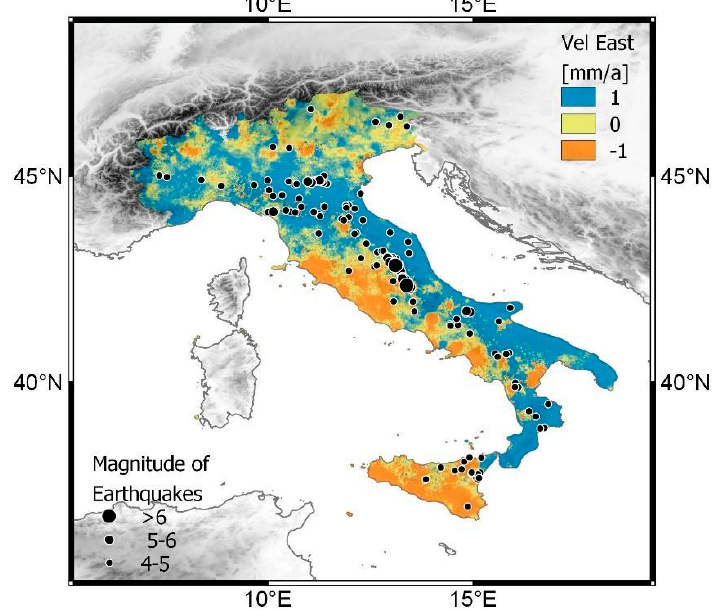
Figure 1. Map of the East component of the ground velocity field of the Italian Peninsula, derived from Global Navigation Satellite Systems (GNSS) and synthetic aperture radar interferometry (InSAR) during more than two decades of observation (1990–2017). The area of the Central Apennines presents major earthquakes from 1990 to present day. From the figure above, it is clear that the main seismogenic areas are linked to the boundary that divides the two blocks with opposite E–W components of velocity.